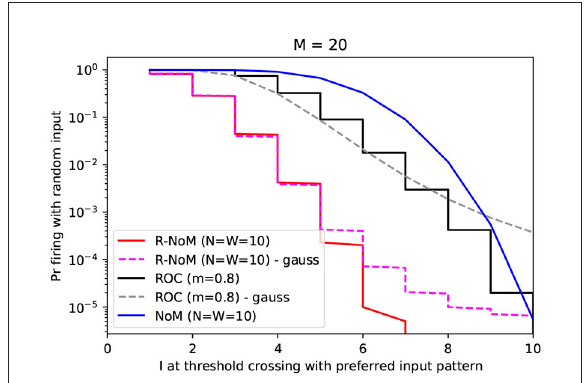
FIGURE5 Speed-accuracy trade-off. Here, we represented, for the different codes, the probability of firing to random inputs as a function of I at threshold crossing for the preferred pattern (both variables depend on the threshold which is varied, but not represented on this figure). Solid lines indicate the probabilities estimated by Monte Carlo simulations (n=2.10 5 runs for each value). Dashed lines indicate the probability assuming a Gaussian distribution for the potential, with the mean and variance computed from Table 3 formulas. These Gauss-based values match well the simulations for low latencies. For higher latencies, they tend to overestimate the FA rate. This suggests that the potential is roughly normally distributed everywhere except in the right tail of the